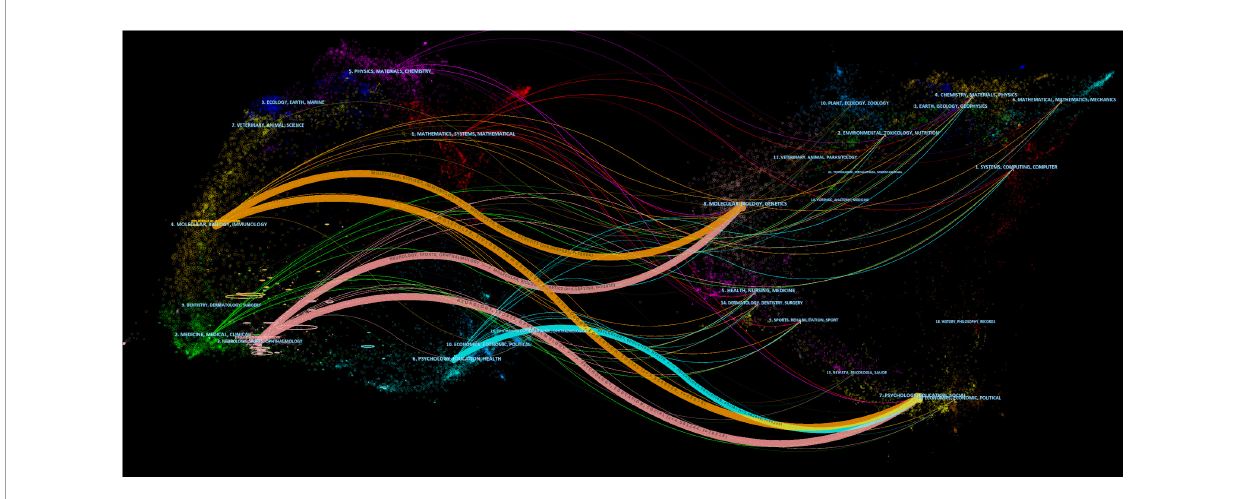
FIGURE5 A dual-map overlay of journals related to research on EEG for MCI. The citing journals are on the left, the cited journals are on the right, and color paths indicate citation relationships. Labels were selected from journal titles to reflect relevant fields.